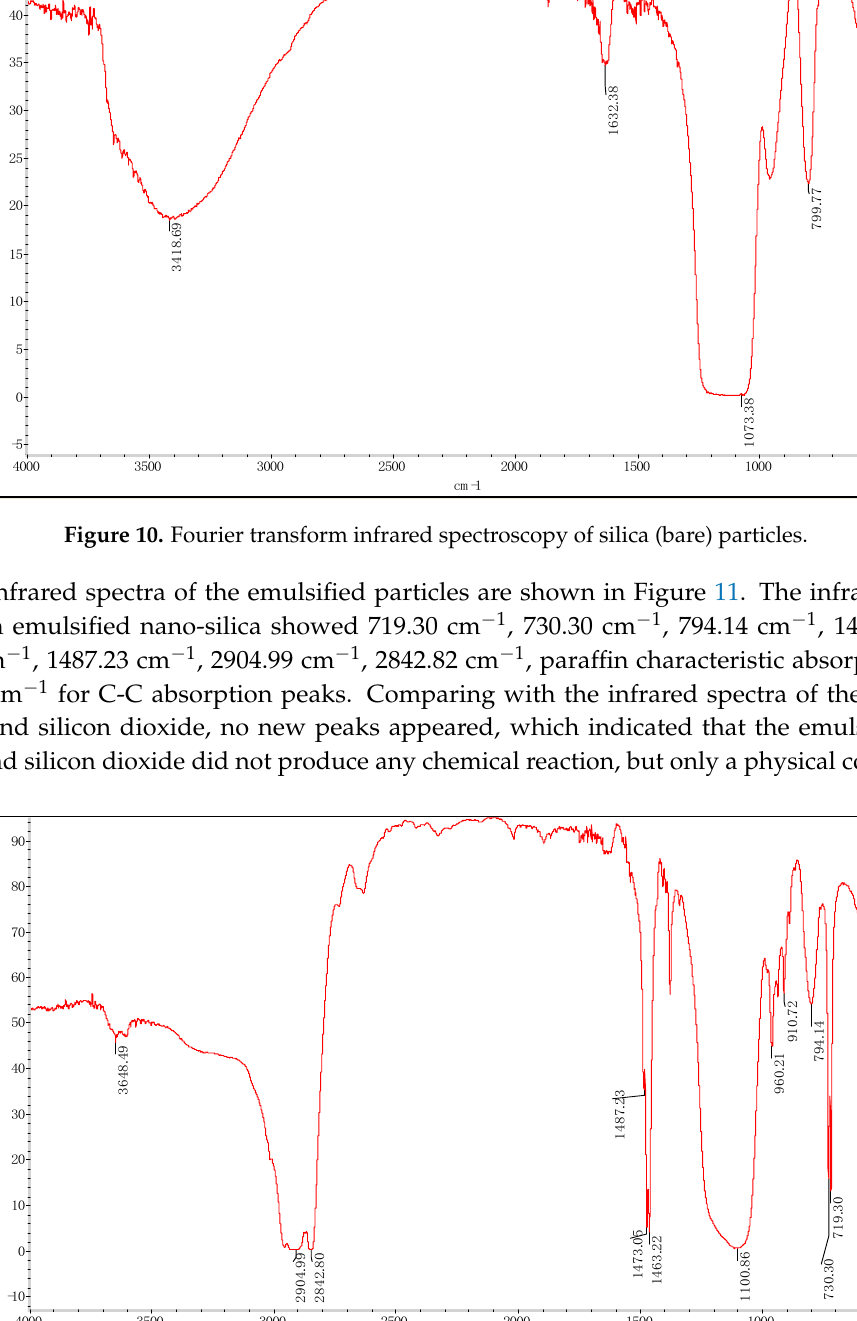
12 of 23 Figure 8. Relation Curve between Intelligent Polymer Flooding Agent Injection Rate and Recovery Rate. Figure 9. Chart oil saturation versus time. 3. Results 3.1. Characterization of Asymmetric Amphiphilic Nanoparticles 3.1.1. Fourier Transform Infrared Spectroscopy